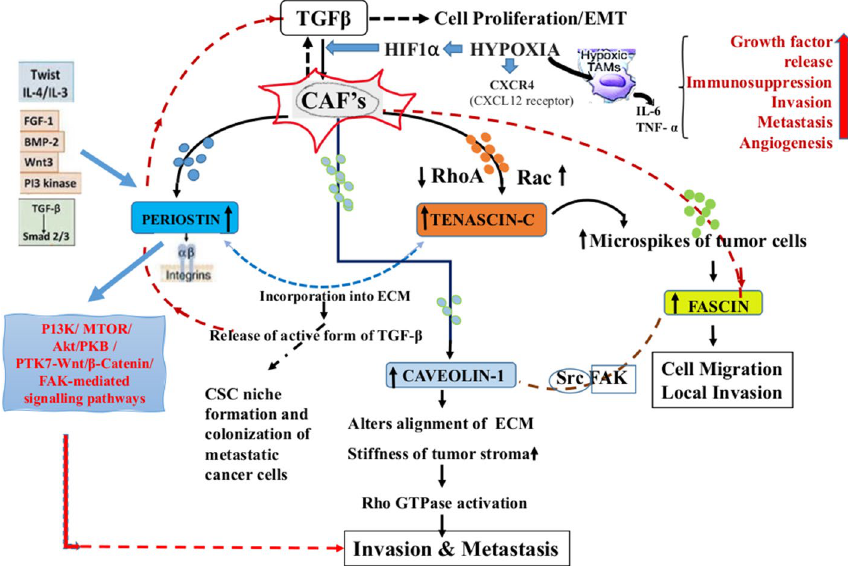
Figure 5. Proposed role of POSTN, TNC, CAV1 and FSCN1, their interaction with each other and CAF’s in OSCC